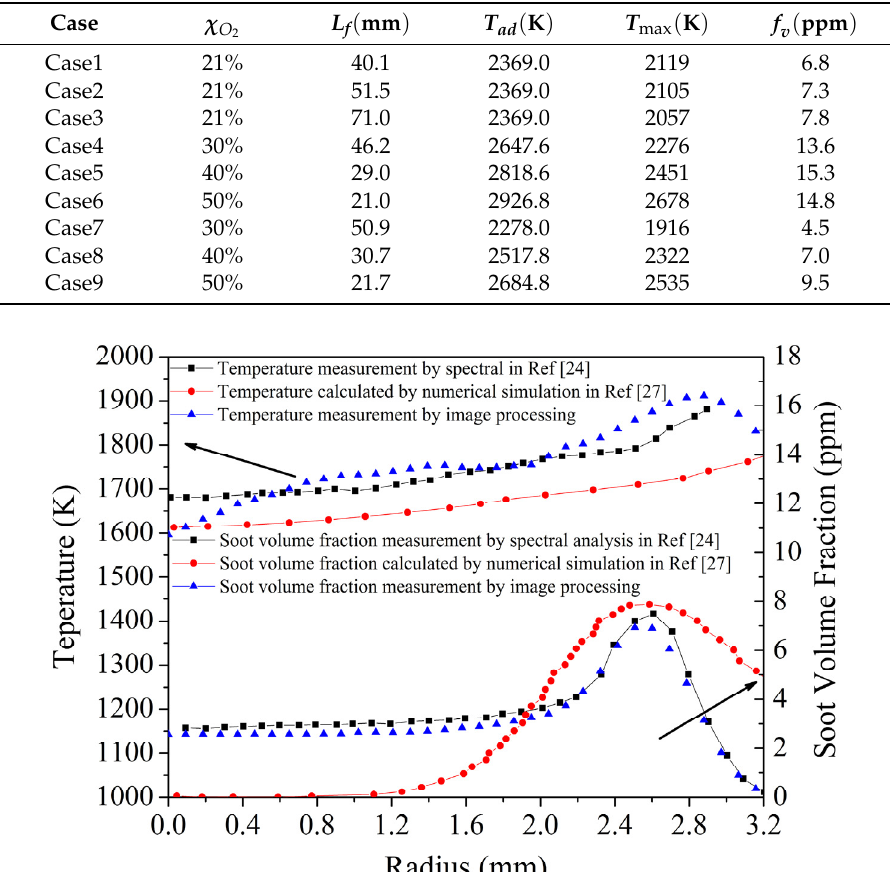
Figure 14. 2-D distributions of temperature T (K) and soot volume fraction (10 − 6 ) for case1.